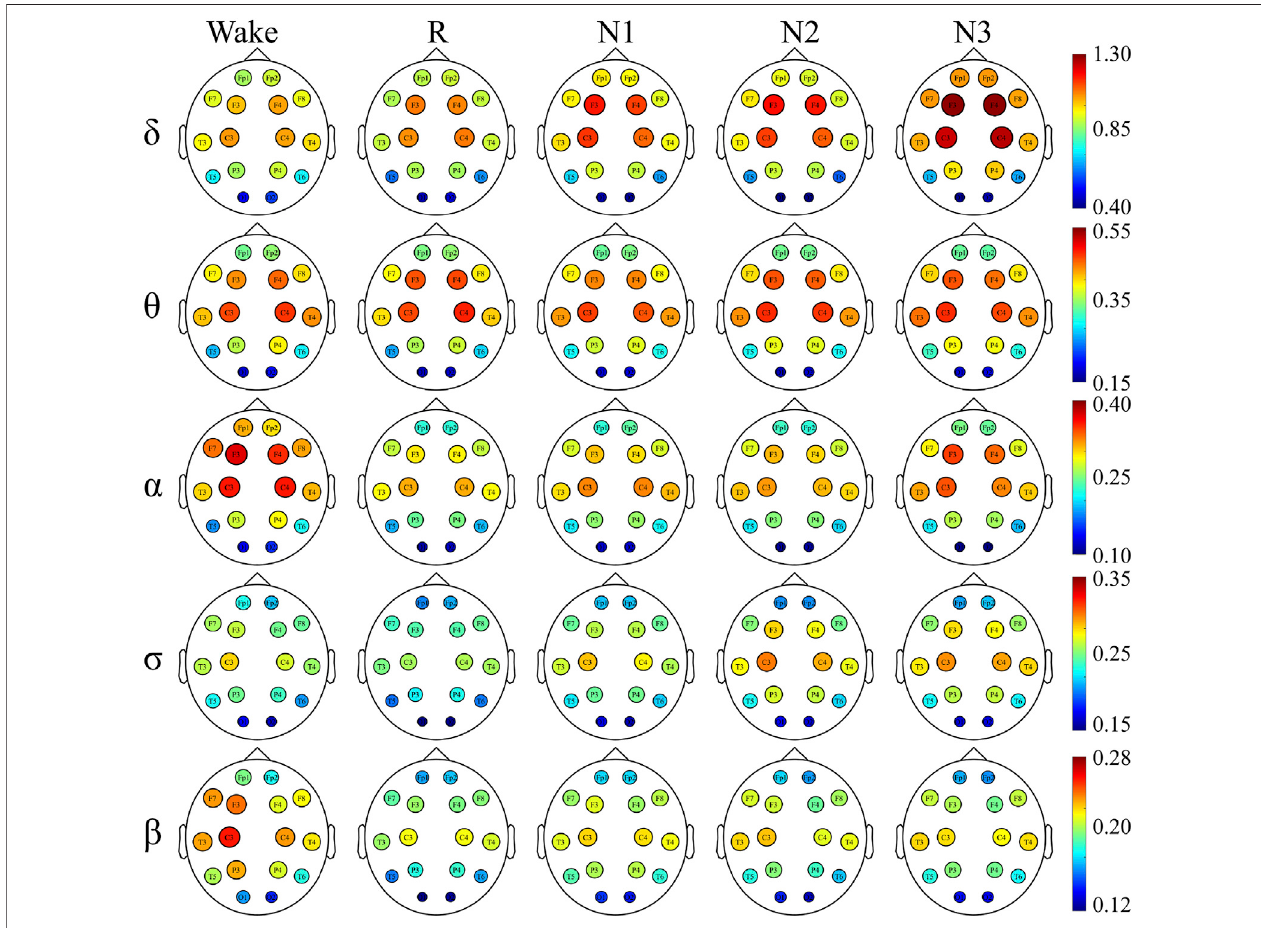
FIGURE 5 | Node strength of the control